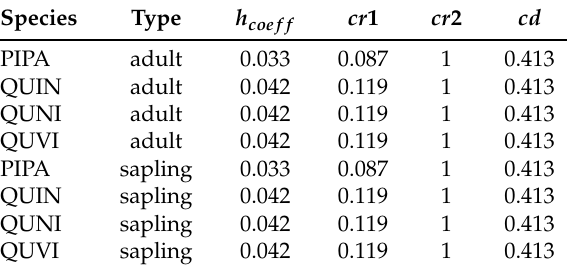
Table A16. Species crown allometry